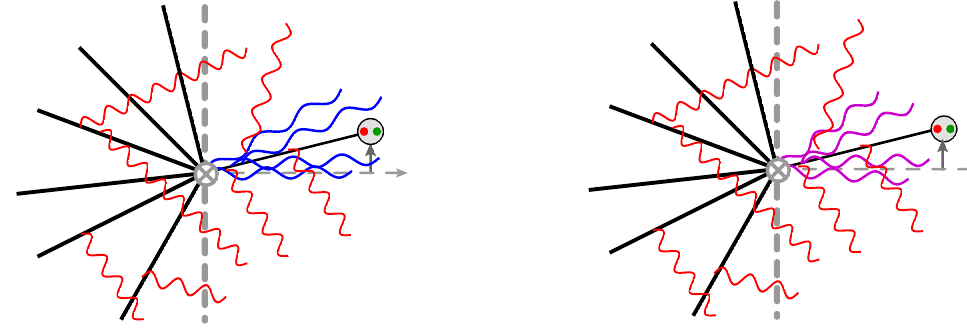
Figure 1 . Hadron transverse momentum ~j T with the thrust axis ˆ n in two different regions. The black lines represent the energetic partons in the unmeasured left hemisphere, while the hadron is measured in the right hemisphere. The vertical dashed line represents a plane that is perpendicular to the thrust axis and that divides the space to the left and right hemisphere. The red curves denote soft radiations from the energetic partons with the virtuality of j T . The blue lines in the left panel describe collinear radiations along the thrust axis, while the purple ones in the right panel give collinear-soft (c-soft)